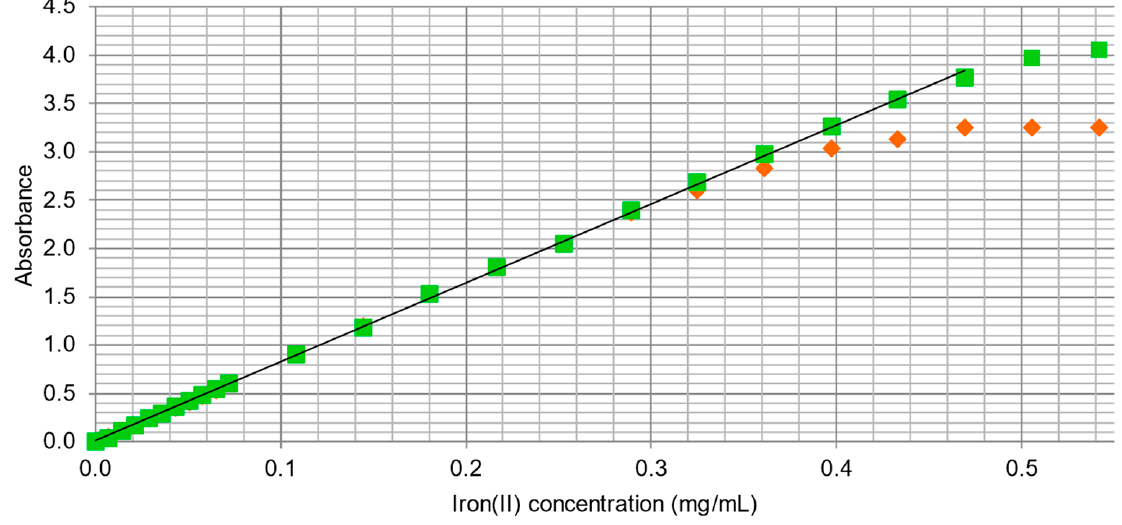
Figure A1. Linearity ranges of calibration functions of a spectrophotometer (orange rhombs) and a laser photometer mode of a thermal-lens spectrometer (green squares) for ferroin solutions in water. Setup, TLS-60; wavelength, 488.0 nm; excitation power, 1 W.